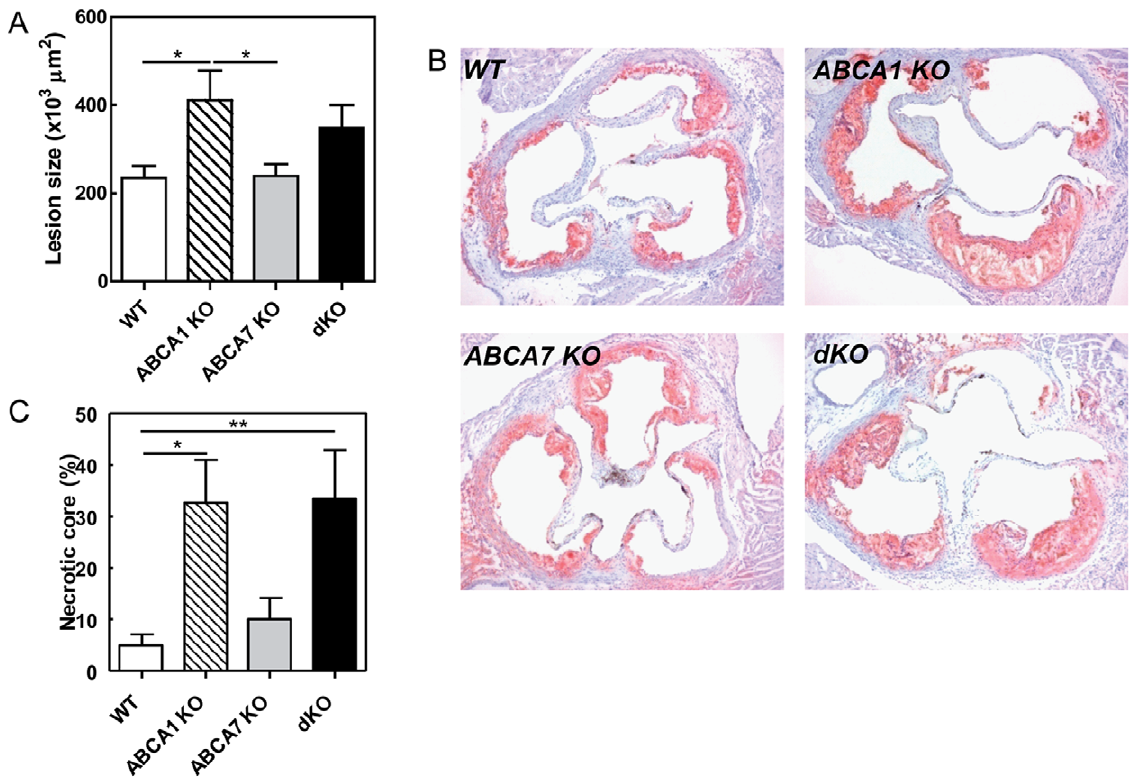
Figure 4. Atherosclerosis in the aortic root of LDLr KO mice reconstituted with WT, ABCA1 KO, ABCA7 KO and dKO bone marrow. ( A ) The mean lesion area ( m m 2 ) was calculated from Oil red O-stained cross-sections of the aortic root at the level of the tricuspid valves. ( B ) Representative pictures are shown. ( C ) The percentage of necrotic core of the total lesion was analysed using TUNEL staining. Values represent the mean 6 SEM of $ 6 mice per group. Statistically significant difference *p , 0.05.